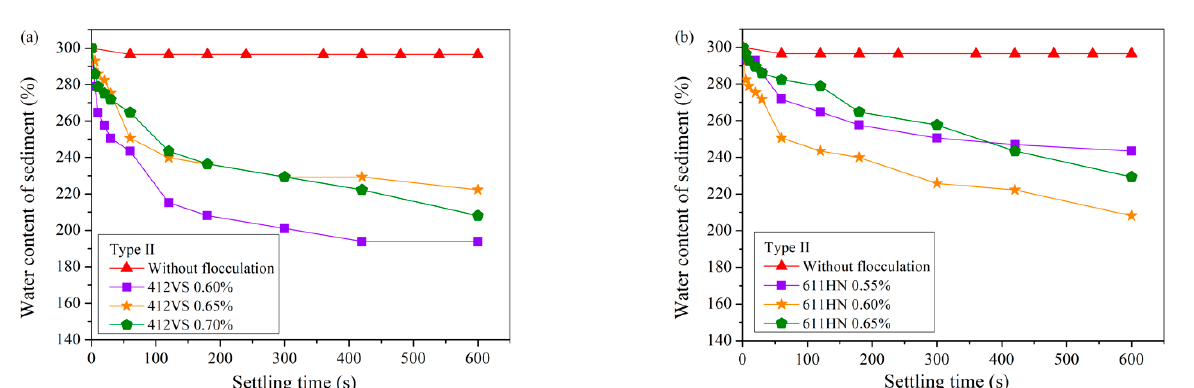
Figure 3. Sedimentation results of slurry (Type Ⅰ ) after pretreatment with CPAM. ( a ) 412VS. ( b ) 611HN.